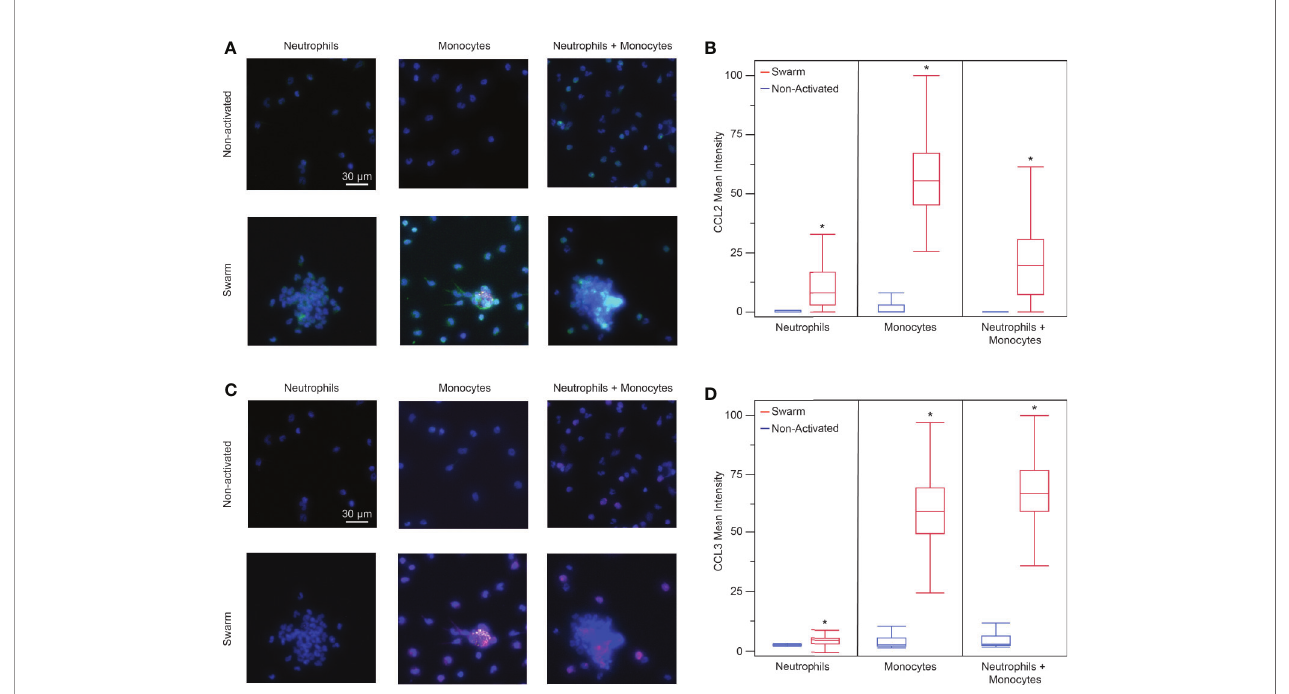
FIGURE 5 | (A) Fluorescence images of neutrophils, monocytes, and neutrophils + monocytes (left to right) stained for CCL2. Top: non-activated cells (no bioparticle targets) Bottom: cells on bioparticle targets (blue: nuclei, green: CCL2, yellow: bioparticle target, scale bars: 30 µm) (B) Neutrophils, monocytes, and the mixture of neutrophils and monocytes released CCL2 when exposed to bioparticle targets. (mean fl uorescence intensity 15.5 ± 38.6, n = 92 cells for neutrophils; 51.4 ± 18.8, n = 970 cells for monocytes; and 18.1 ± 13.8, n = 579 cells for neutrophils + monocytes, Anova, *p < 0.0001 for each condition). There was no signi fi cant difference between the non-activated cells and IgG controls (Anova, a = 0.05). The monocyte CCL2 signal was higher than that of the neutrophils or that of the neutrophil + monocyte mixture (Anova, p < 0.001). There was no signi fi cant difference between the neutrophil and the neutrophil + monocyte mixture CCL2 signals (Anova, a = 0.05) (C) Fluorescence images of neutrophils, monocytes, and neutrophils + monocytes (left to right) stained for CCL3. Top: non-activated cells (no bioparticle targets) Bottom: cells on bioparticle targets (blue: nuclei, magenta: CCL3, yellow: bioparticle target, scale bars: 30 µm) (D) Neutrophils, monocytes, and the mixture of neutrophils and monocytes released CCL3 when exposed to bioparticle targets. (mean fl uorescence intensity 5.2 ± 2.4, n = 107 cells for neutrophils, and 60.8 ± 13.9, n = 888 cells for monocytes, 66.9 ± 19.8, and n = 456 cells for neutrophils + monocytes, Anova, *p < 0.0004 for each condition). There was no signi fi cant difference between the non- activated cells and IgG controls (Anova, a = 0.05). The CCL3 signal for the neutrophil + monocyte mixture was higher than that of the neutrophils or that of the monocytes (Anova, p < 0.001). Additionally, the CCL3 signal from the monocytes was higher than that of the neutrophils (Anova, a =